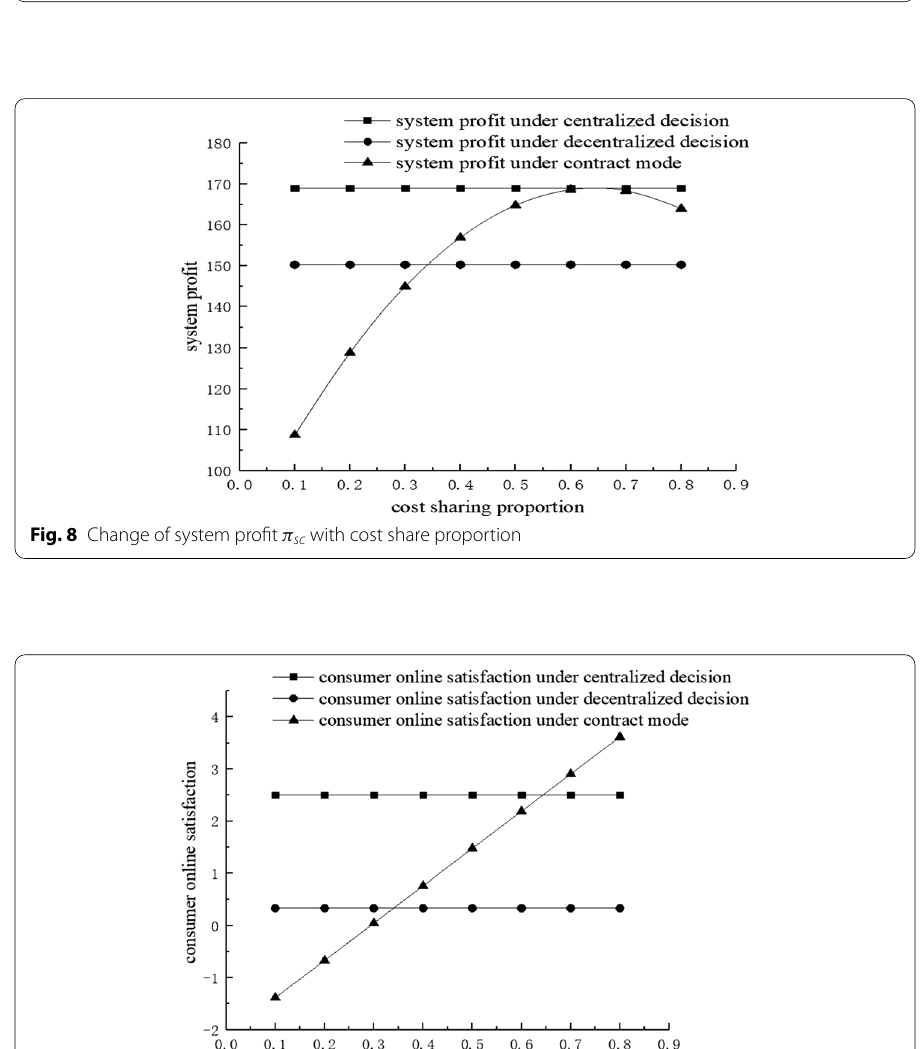
Fig. 7 Change of product arrival time T with cost share proportion